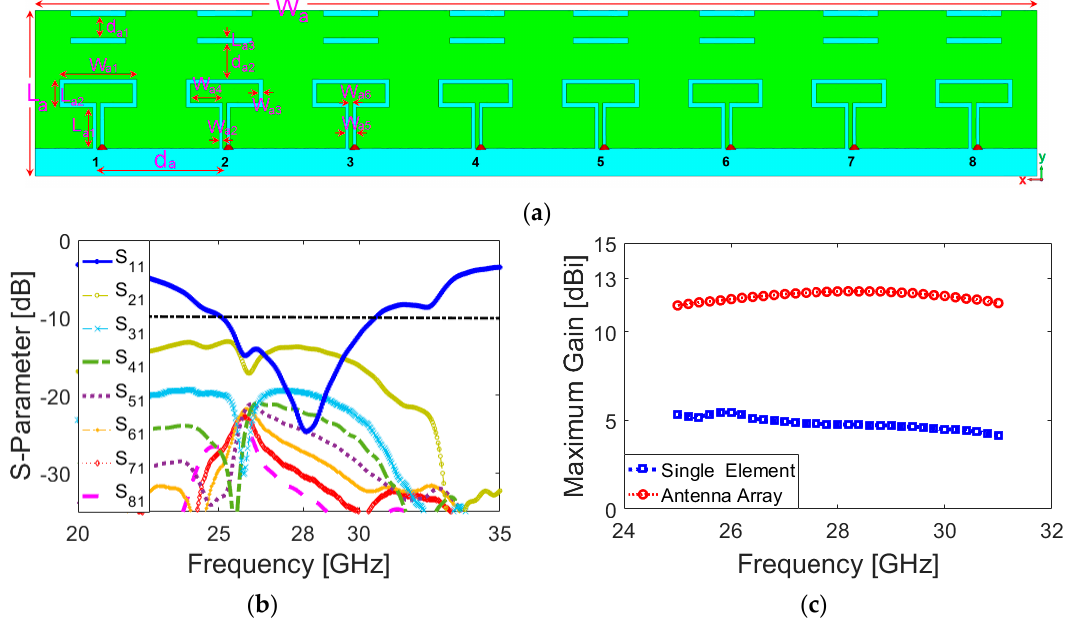
Figure 19. ( a ) Design details and configuration of the array, ( b ) its S-parameters, and ( c ) gain comparison of the array and the antenna element.